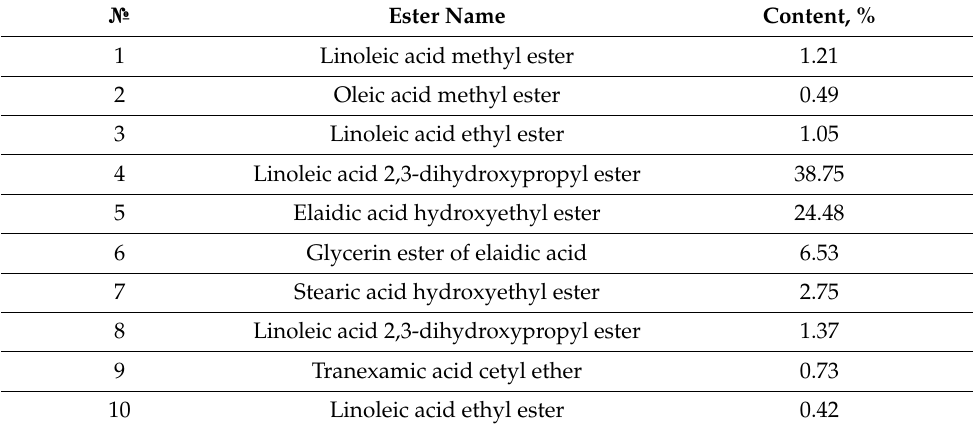
Table 3. The composition of the ester part of bio-additive.